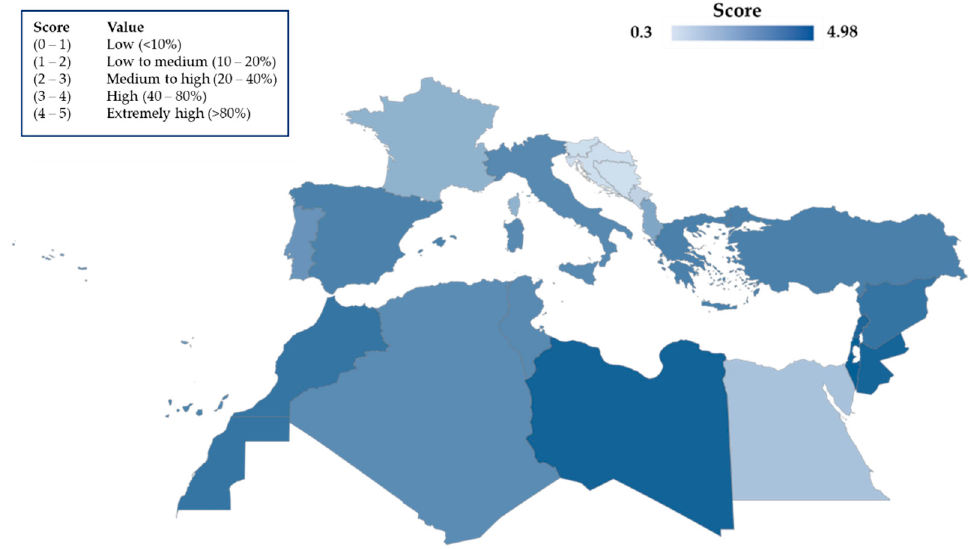
Figure 3. Water stress in Mediterranean Countries, 2020 [25]. ( For Palestine and Malta, there are no literature data ).